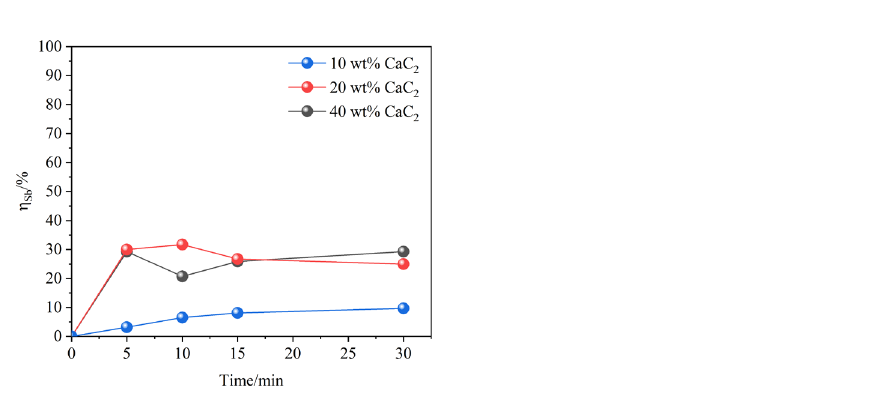
Figure 1. Effect of CaC 2 content in slag on Sb removal ratio at T = 1873 K, slag = 5 wt%, initial Sb = 0.06 wt%, initial C content = 0.05 wt%.